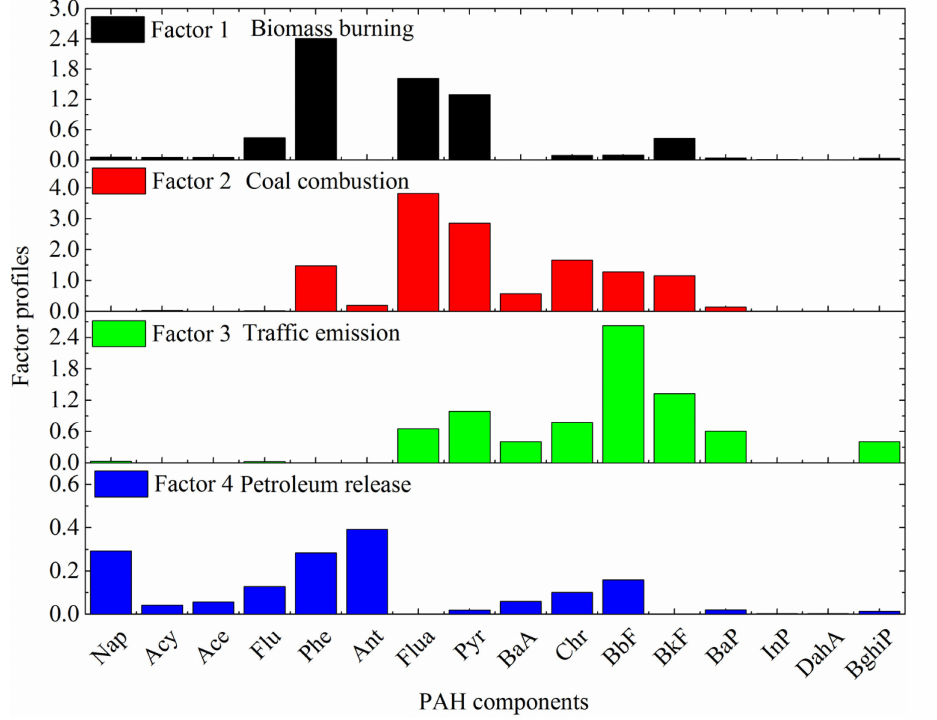
Figure 3. Factor profiles of PAH components in PM 2.5 identified by the PMF